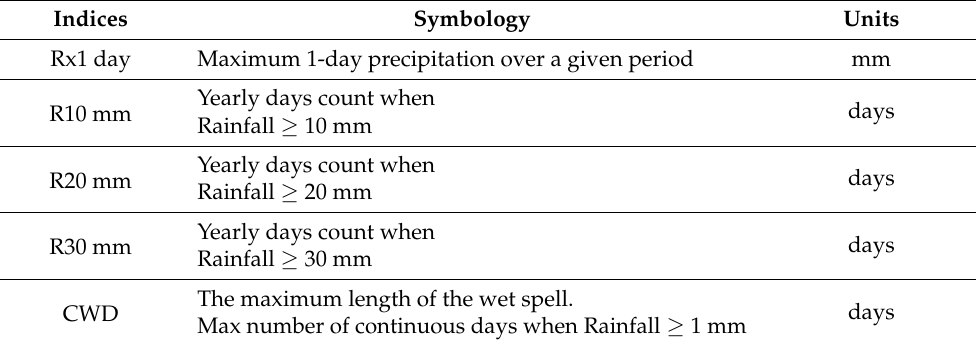
Table 3. Climate indices and their definition (additional details: www.climdex.org (accessed on 3 July